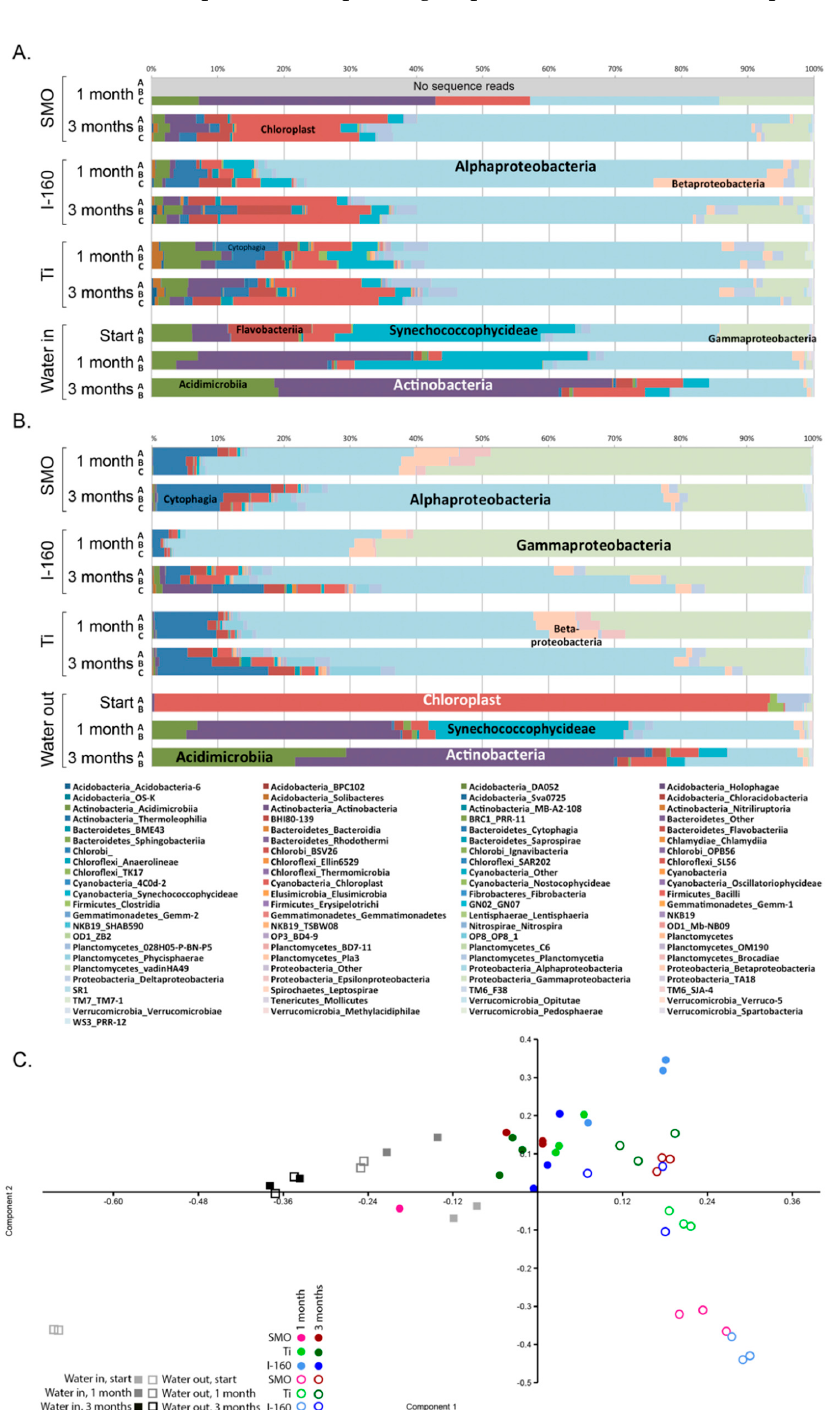
Figure 6. The bacterial community composition of ( A ) the non-chlorinated and ( B ) chlorinated samples; ( C ) a PCA plot based on the bacterial community (family level). In ( C ), open symbols indicate chlorinated and solid symbols non-chlorinated samples. Component 1 explains 39.2% and Component 2 explains 26.2% of the variance, with Actinobacteria, Chloroplasts, Alphaproteobacteria and Epsilonproteobacteria dominating the axis loadings.